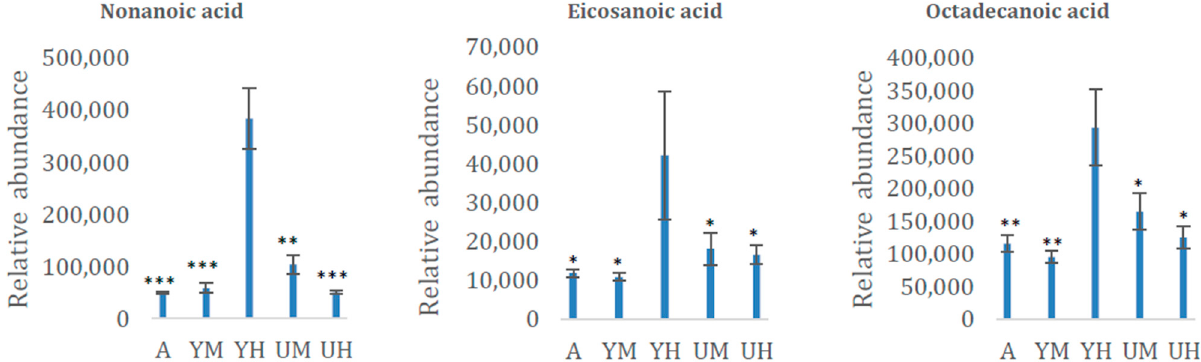
Figure 4. Relative contents (means ± standard deviation, n = 8) of three fatty acids in the Chlorella cultures after 8 days of cultivation in the following growth conditions: autotrophic (AUTO), mixotrophic with glycerol (GLY MIXO), heterotrophic with glycerol (GLY HETE), mixotrophic with glucose (GLU MIXO), heterotrophic with glucose (GLU HETE). The data are presented as means ± standard deviations, n = 8. *, **, *** indicate significant differences in metabolite concentration relative to cultures grown in heterotrophic conditions with glycerol according to Student’s t -test, p < 0.05, 0.01, and 0.001, respectively.